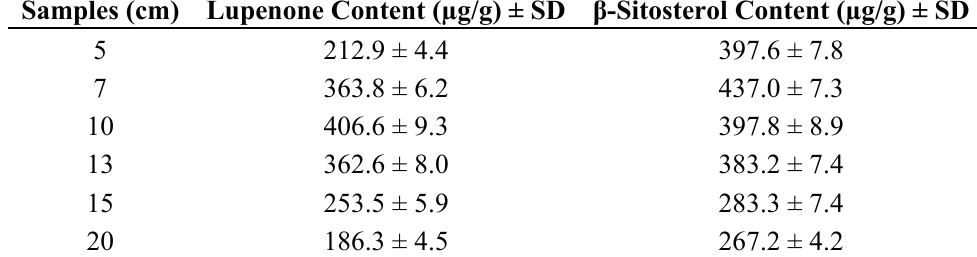
Table 7. Levels of lupenone and β -sitosterol in Rhizoma Musae samples at different growth